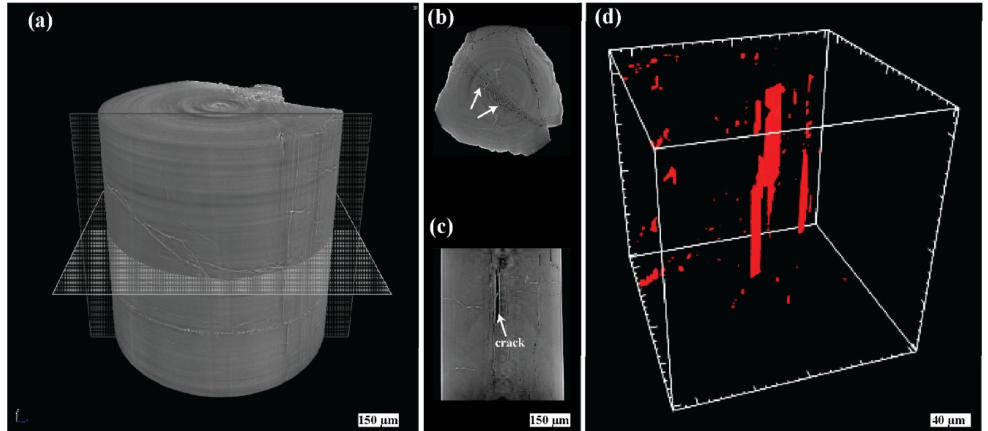
Figure 4. Synchrotron X-ray computed micro-tomography of tourmaline 7: ( a ) volume rendering of the sample; ( b ) reconstructed axial slice; ( c ) the cross section of the stack of reconstructed slices; ( d ) volume rendering of pores and cracks, a